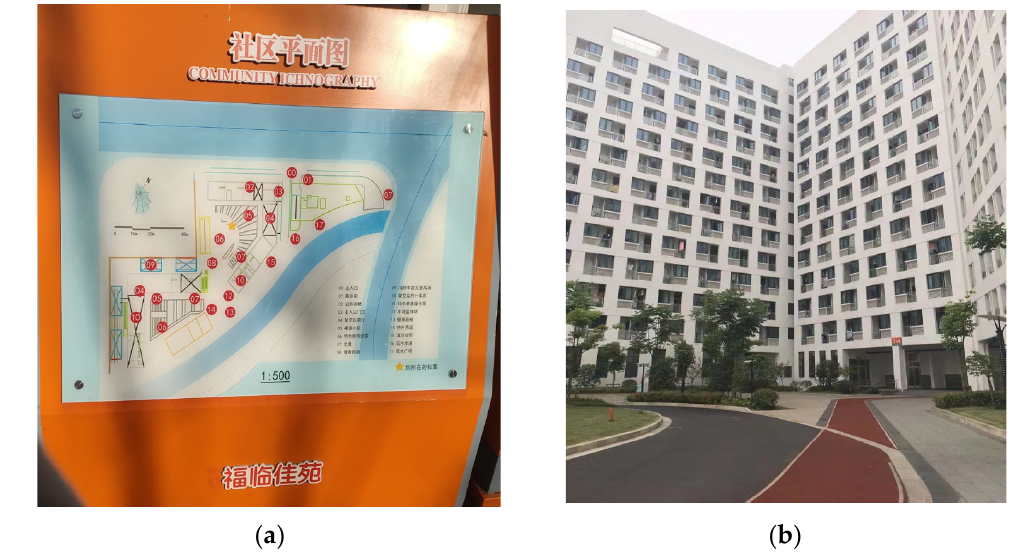
Figure 3. Photos of Fulinjiayuan Court (Source: the authors): ( a ) Layout of the complex; ( b ) Residen- tial building.